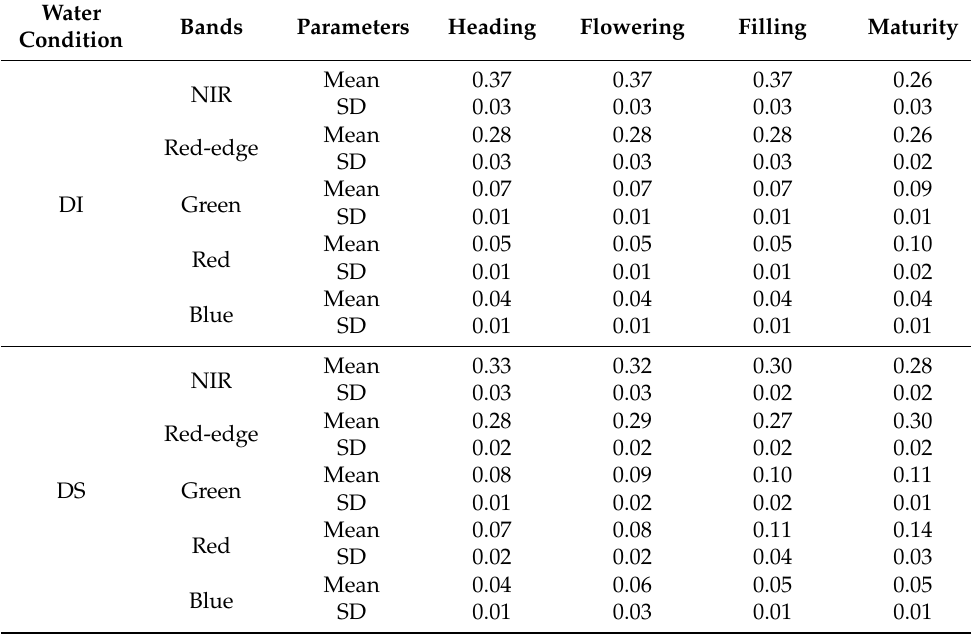
Table 1. Mean and standard deviation (SD) of NIR, red-edge, green, red, and blue reflectance for wheat at different growth stages under normal irrigation (NI) and drought stress (DS)